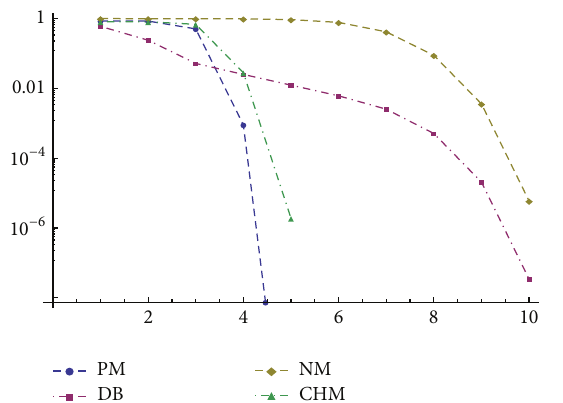
Figure 1: The log plot for the comparison of number of iterations in Example